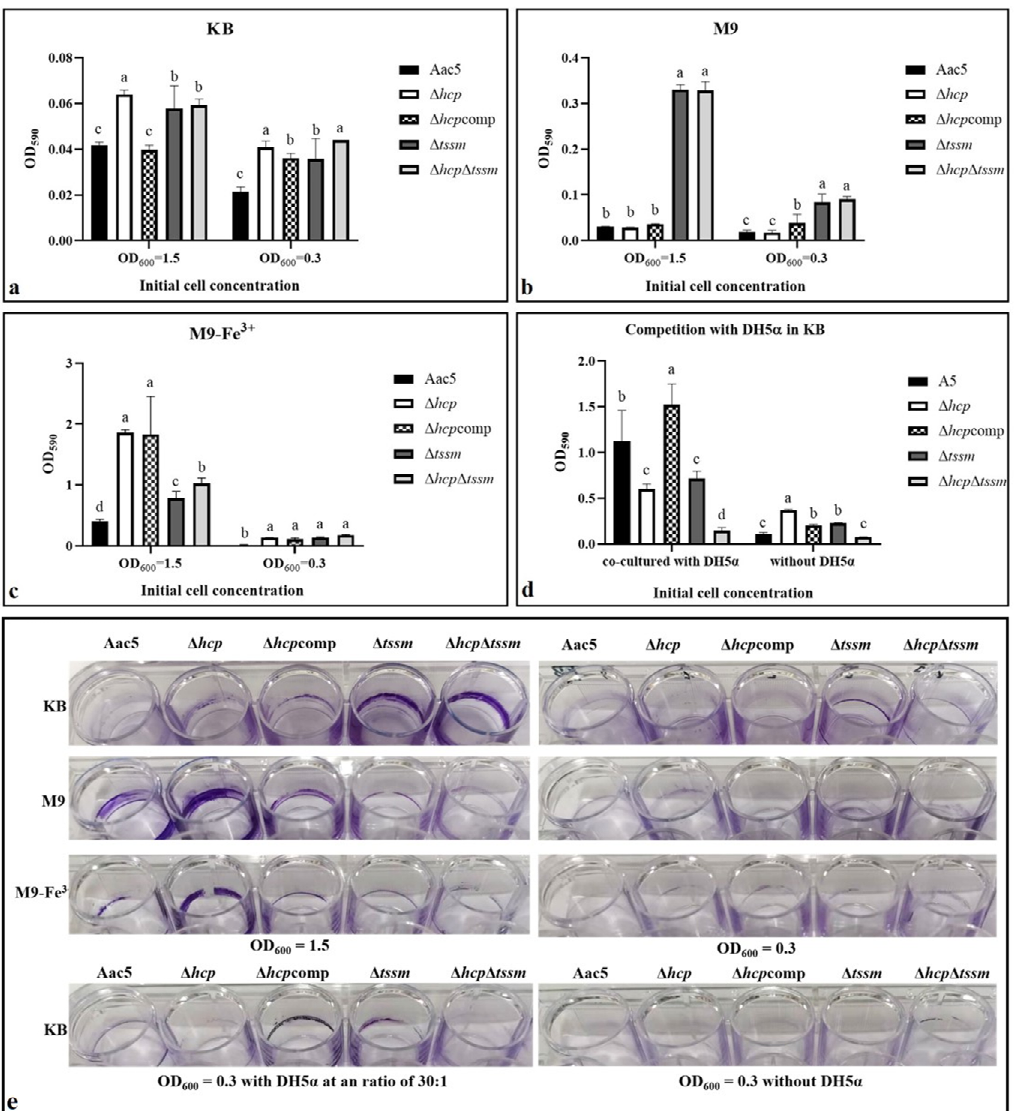
Figure 4. Biofilm formation of Acidovorax citrulli strain Aac5, ∆ hcp , ∆ hcp comp, ∆ tssm , and ∆ hcp ∆ t ssm grown on three different media, and under competition conditions. ( a – c ) Quantification of biofilm formation of cells grown in KB, M9, and M9-Fe 3+ (12.5 mmol·L − 1 ) media at an initial cell concentration of OD 600 = 0.3 and 1.5 by measuring absorbance at OD 590 . ( d ) Biofilm formation of cells grown in KB with E . coli DH5 α at an ratio of 30:1. ( e ) Qualitative visualization of biofilm formation of strains grown on KB, M9, and M9-Fe 3+ media at an initial cell concentration of OD 600 = 0.3 and 1.5, and under competition conditions with E . coli DH5 α . Significant differences were found between different letter substitutes on the column calculated by Duncan’s new multiple range test (p = 0.05).